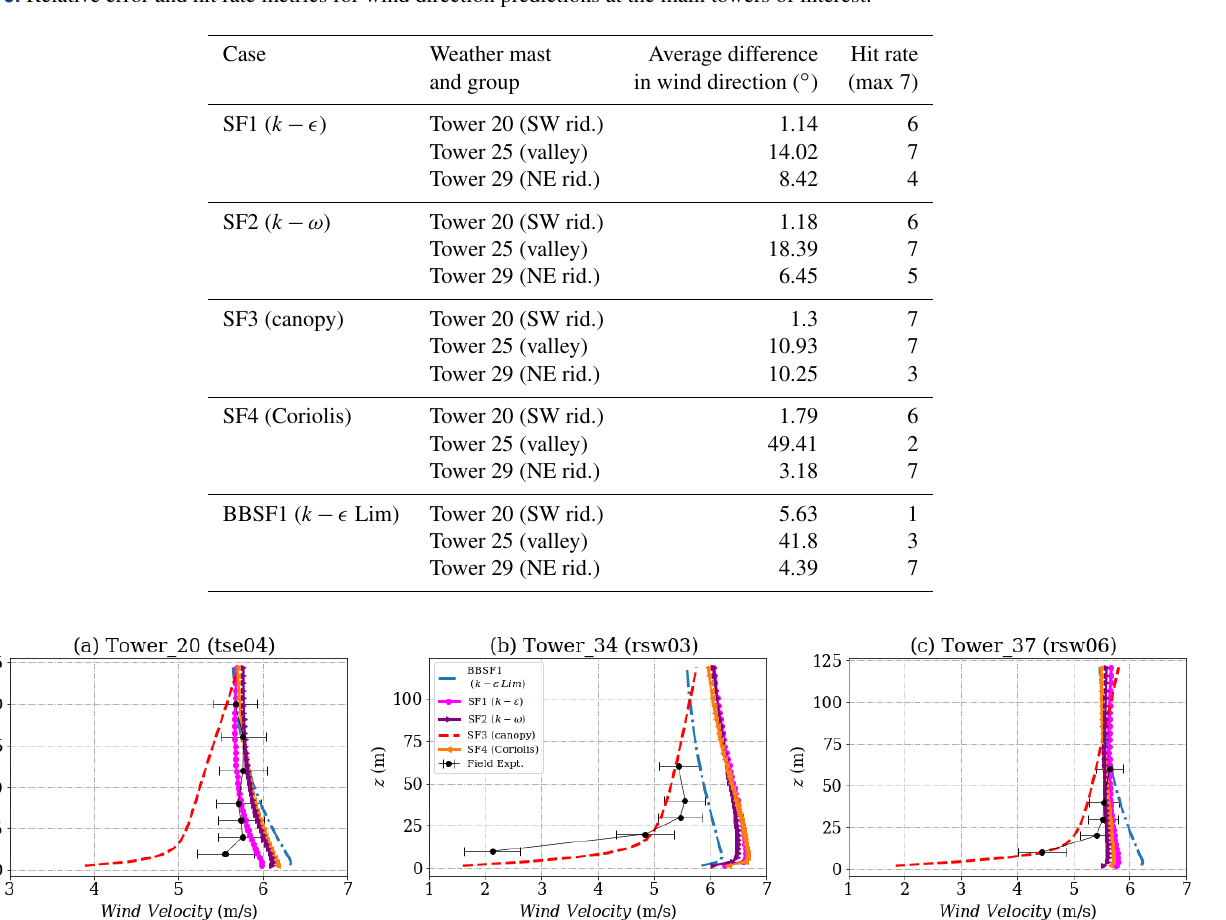
Table 6. Relative error and hit rate metrics for wind direction predictions at the main towers of interest.